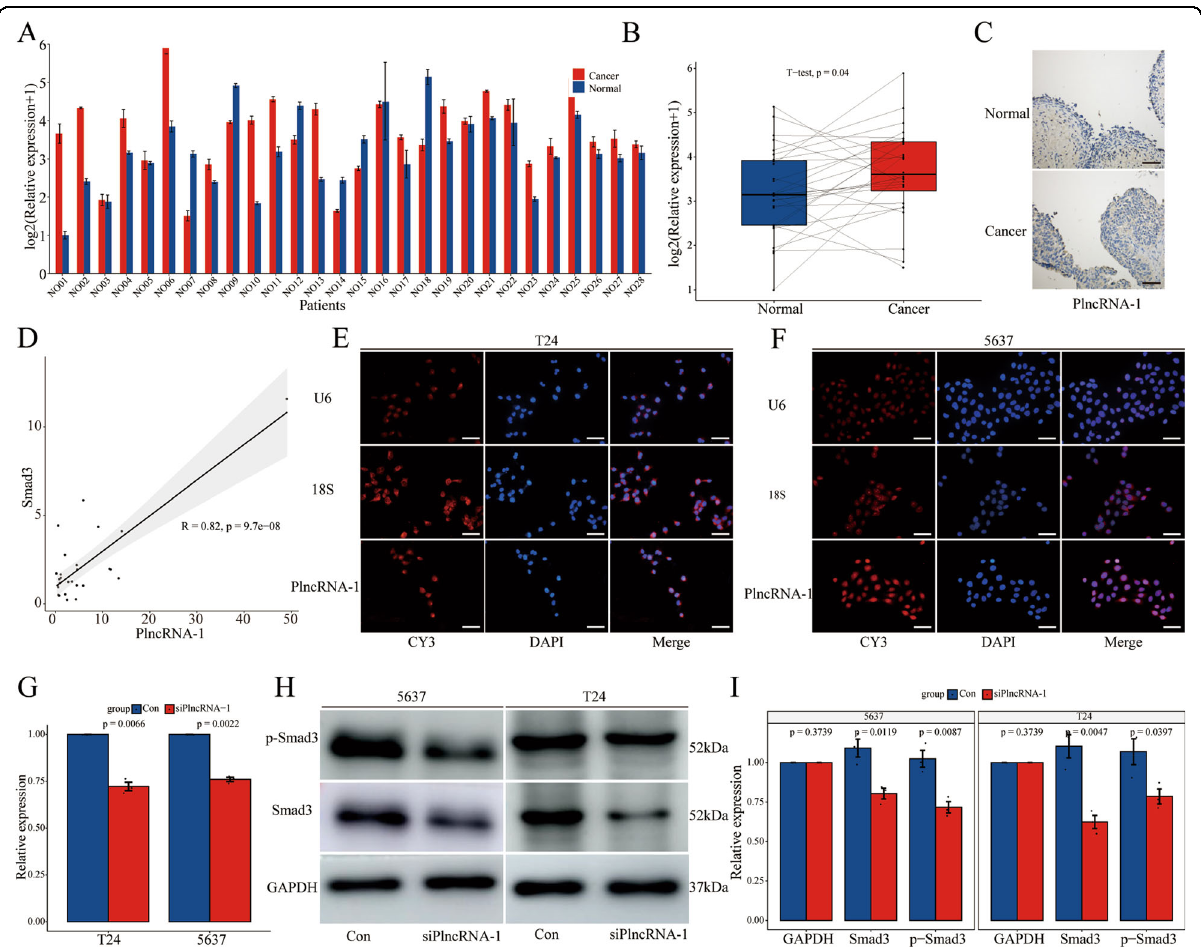
Fig. 5 Regulation of smad3 expression by PlncRNA-1. A , B The expression level of smad3 in 28 pairs of normal and BC tissues. C The associations between PlncRNA-1 expression levels and smad3 in BC tissues. D – F RNA-FISH images for subcellular localization of PlncRNA-1 in BC cells (Scale bar, 50 μ m). G qPCR analysis for the expression level of smad3 in PlncRNA-1 silent BC. H , I Western blot for the expression level of smad3 in PlncRNA-1 silent BC